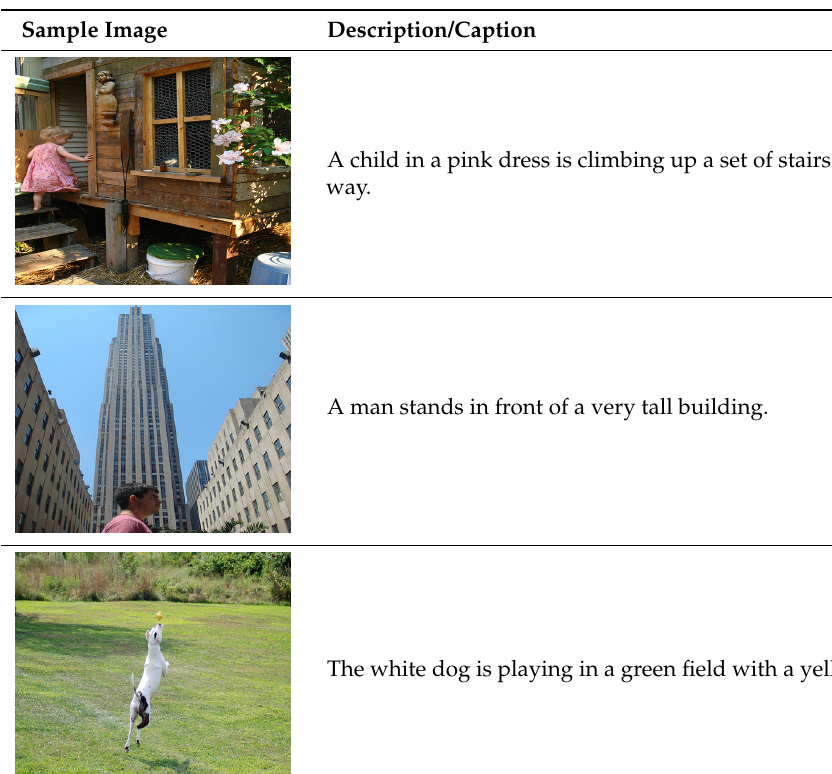
Table 3. Sample Image and